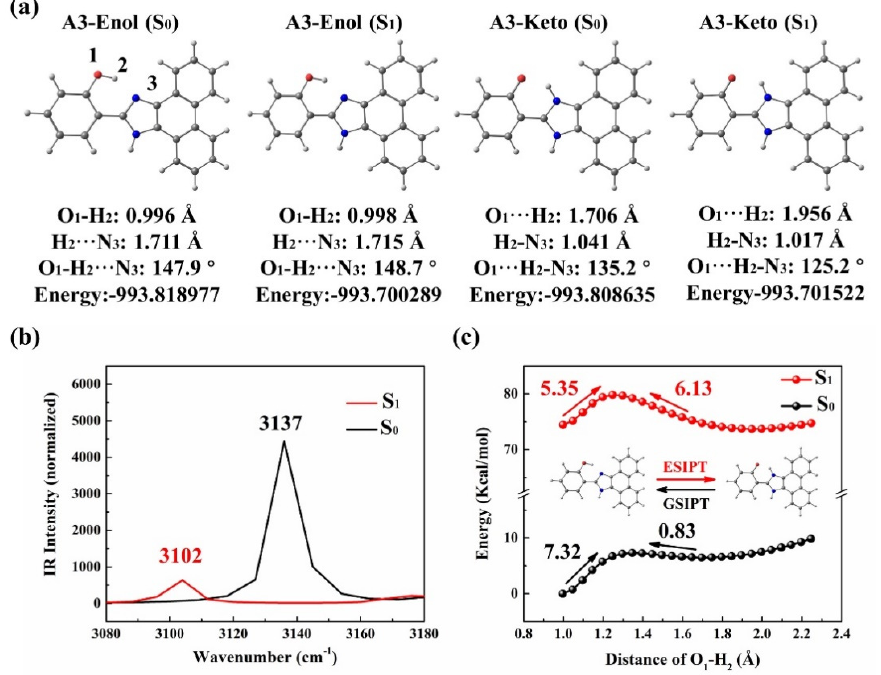
Figure 2. B3LYP − D3/TZVP/IEFPCM-optimized geometries of A3 − Enol and A3 − Keto in the S 0 state ( a ); IR vibrational spectra of A3 involved in O 1 − H 2 stretching modes in S 0 and S 1 states ( b ); Potential energy curves of the S 0 and S 1 states for A3 along with O 1 − H 2 ∙∙∙ N 3 ( c ).